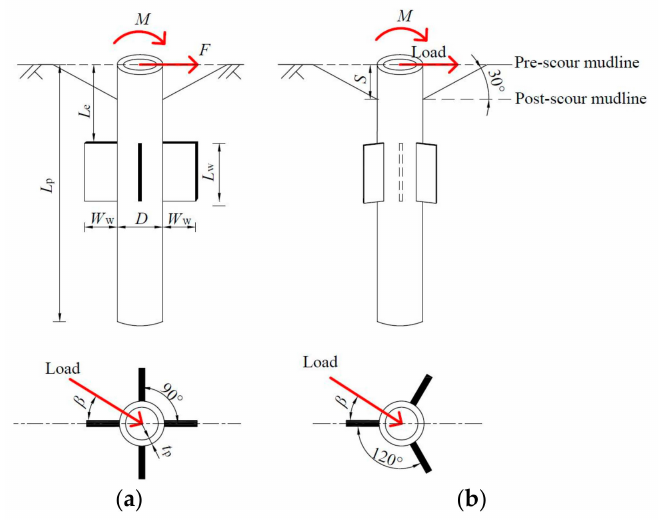
Figure 1. Schematic diagram of the winged monopile model: ( a ) a four-wing monopile; ( b ) a three-wing monopile.